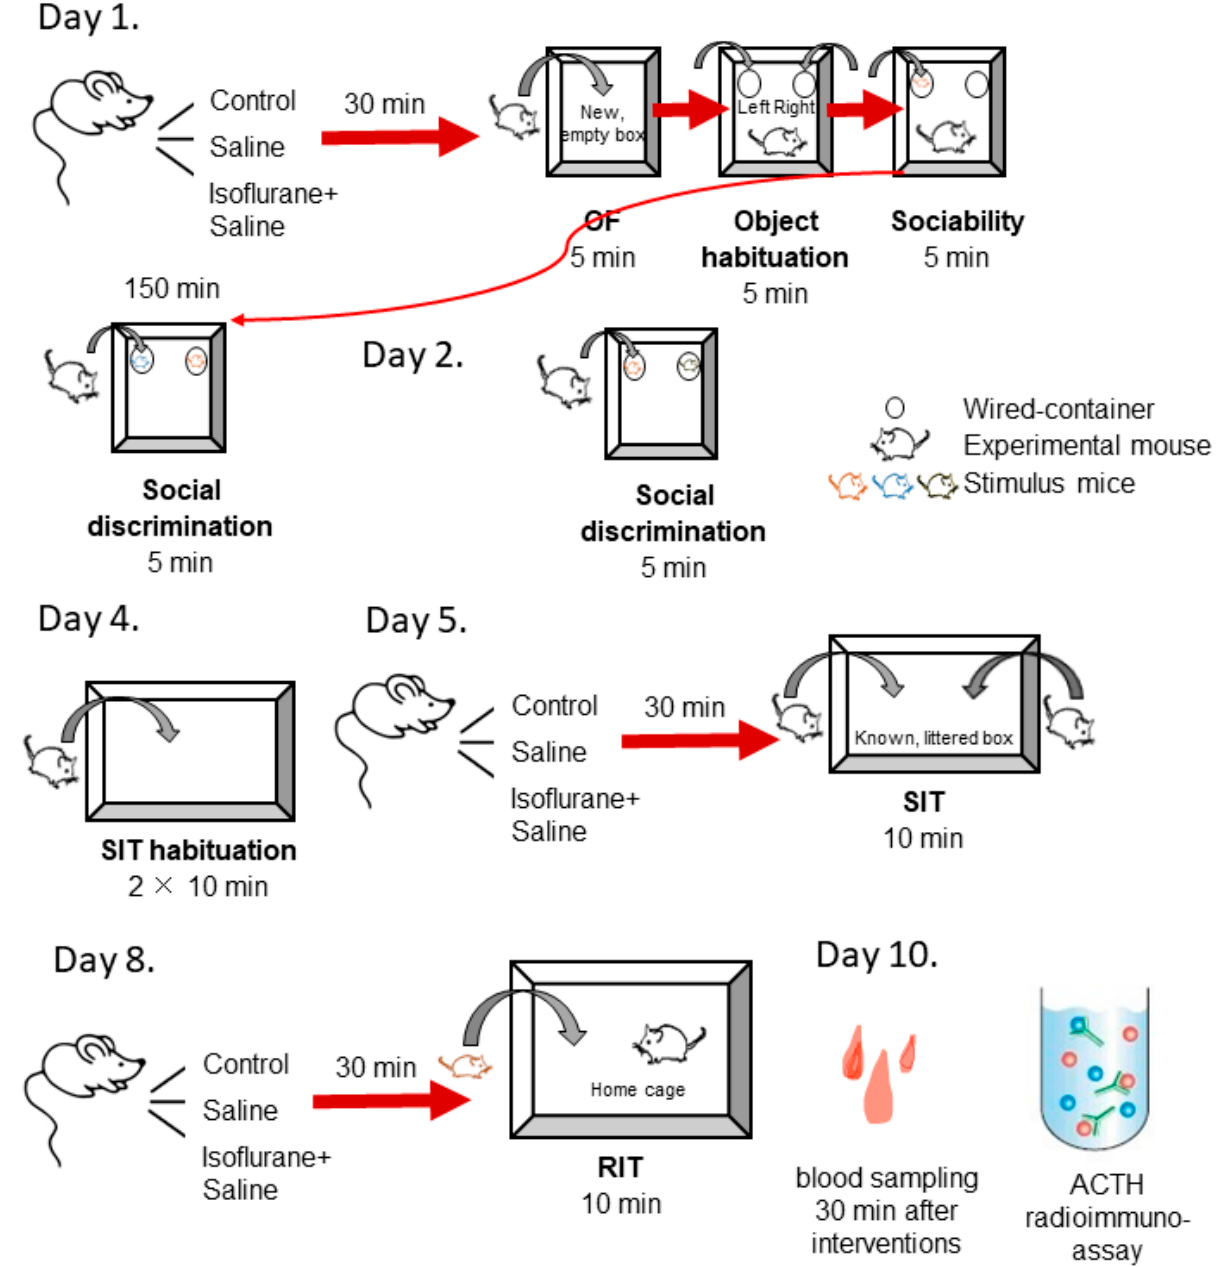
Figure 1. Timeline of the experiment. Three groups of C57Bl/6 male mice were compared: control, without any intervention (n = 11); saline, injected intraperitoneally with physiological saline (1 mg/10 mL/kg) 30 min before behavioural testing (n = 10); isoflurane+saline, isoflurane inhalation until loss of consciousness followed by saline injection as in the previous group (n = 10). Abbrevia- tions: OF: open field; SIT: social interaction; RIT: resident–intruder test.